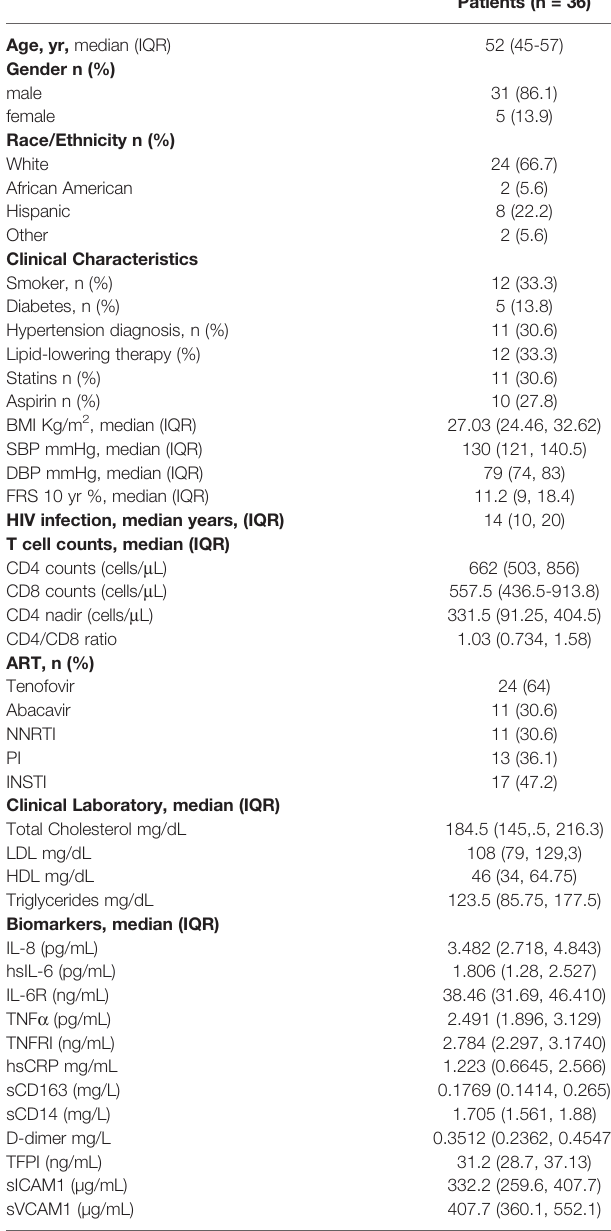
TABLE 1 | Patient